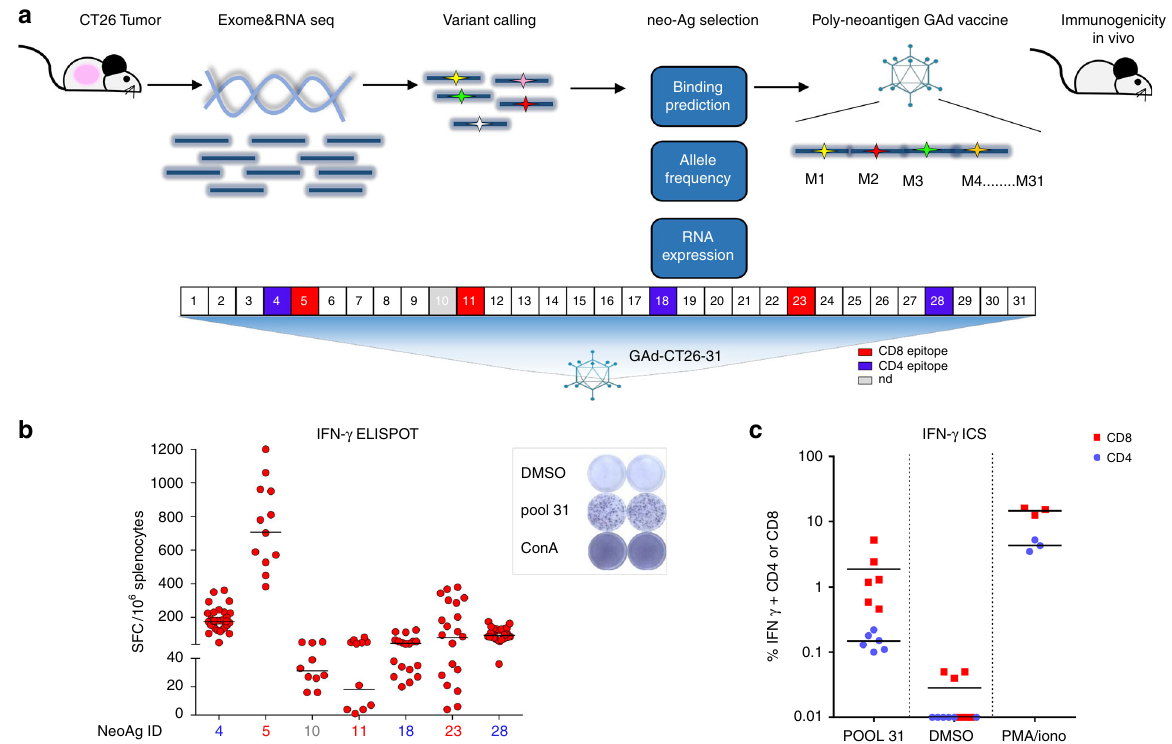
Fig. 1 In vivo immunogenicity of GAd encoding CT26 neoantigens. a Schematic of the approach used to identify CT26 tumor speci fi c mutations and generation of the vaccine; analysis of non-synonymous single nucleotide variants on DNA and RNA NGS allowed the selection of 31 nAgs, which were prioritized according to (i) MHC class I (predicted IC50 ≤ 500 n M ) and II (binding score ≤ 1) binding predictions, (ii) tumor allele frequency (MAF ≥ 25%), and (iii) RNA expression ( ≥ 1 mutated RNA read). Selected nAgs were cloned in tandem in a GAd vector and tested in vivo. b In vivo immunogenicity of GAd-CT26-31. T-cell responses were measured by IFN- γ ELISpot on splenocytes of naive mice 3 weeks post immunization with 5 × 10 8 vp of GAd-CT26-31 ( n = 10 – 30 mice/group). Responses against individual nAgs peptides found immunogenic are shown; nAgs ID is in red for nAgs inducing CD8 + T-cell responses or in blue for nAgs inducing CD4 + T-cell responses. Peptide diluent DMSO and Concanavalin A were used as negative and positive control, respectively. Data are representative of three independent experiments. c The quality of induced T-cell responses (CD4, blue circles, and CD8, red squares) was assessed by IFN- γ ICS by using a pool of 31 nAgs peptides (POOL 31) ( n = 6 mice/group, representative of three experiments). Peptide diluent DMSO and PMA/Ionomycin were used as negative and positive control, respectively. SFC = Spot forming cells, ConA = Concanavalin